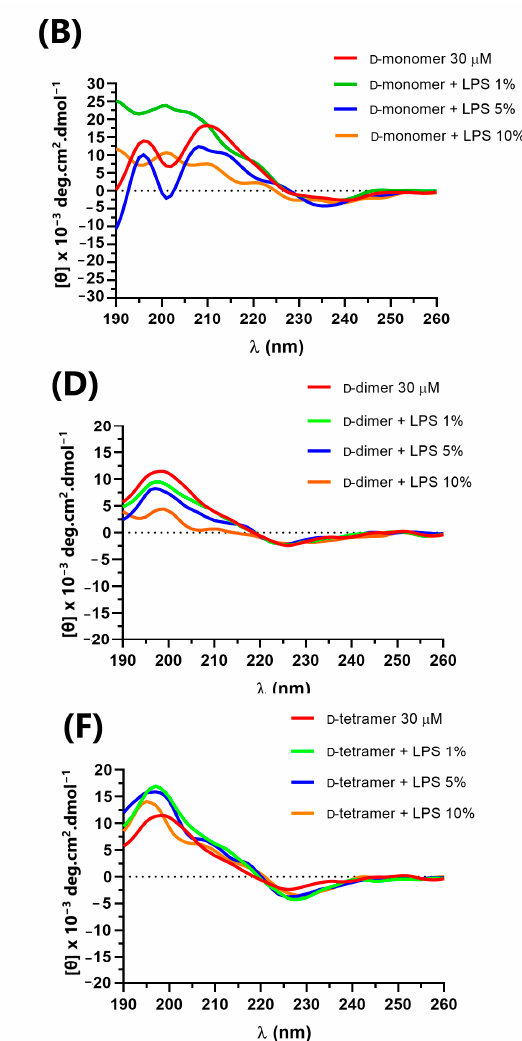
Figure 4. Circular dichroism of peptides: ( A ) L-monomer, ( B ) D-monomer, ( C ) L-dimer, ( D ) D-dimer, ( E ) L-tetramer, and ( F ) D-tetramer at 30 µ M in PBS and in the presence of 1, 5 and 10% LPS.